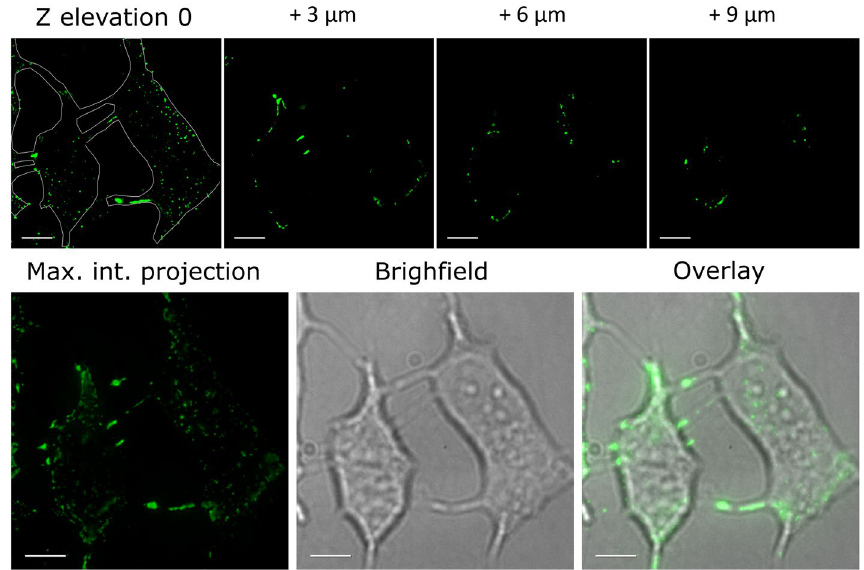
Figure 4. Localization of GZ19-32 (10 nM, green) in hypoxia-grown live HeLa cells shows that CAIX is expressed on the cell membrane, primarily on philopodia. The scale bar length is 10 µm.